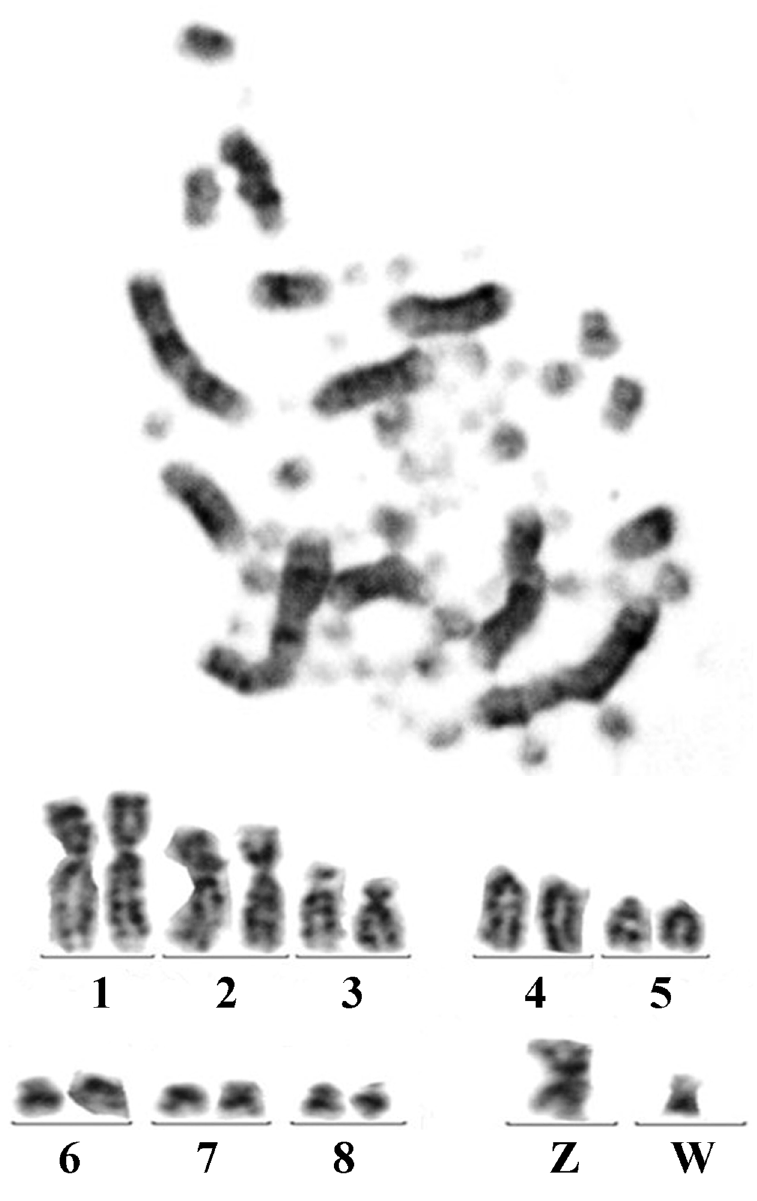
Figure 6. The karyotype of the cultured granulosa